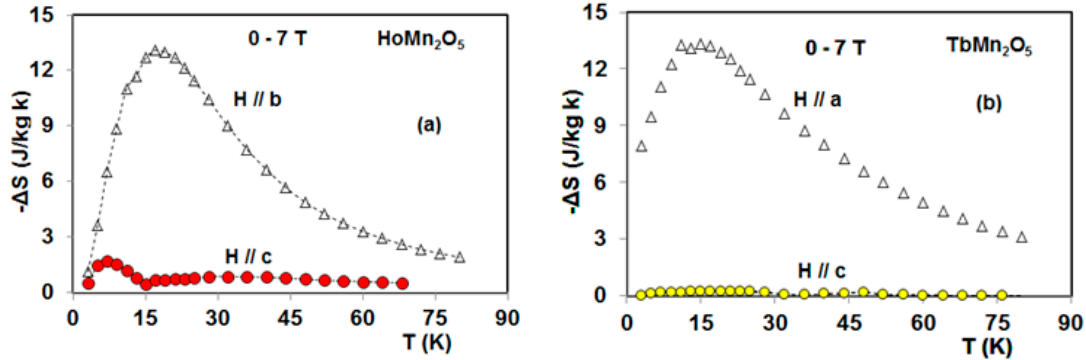
Figure 15. Isothermal entropy change of HoMn 2 O 5 ( a ) and TbMn 2 O 5 ( b ) single crystals under a magnetic field change of 7 T applied along their easy- and hard-axes [19,20].